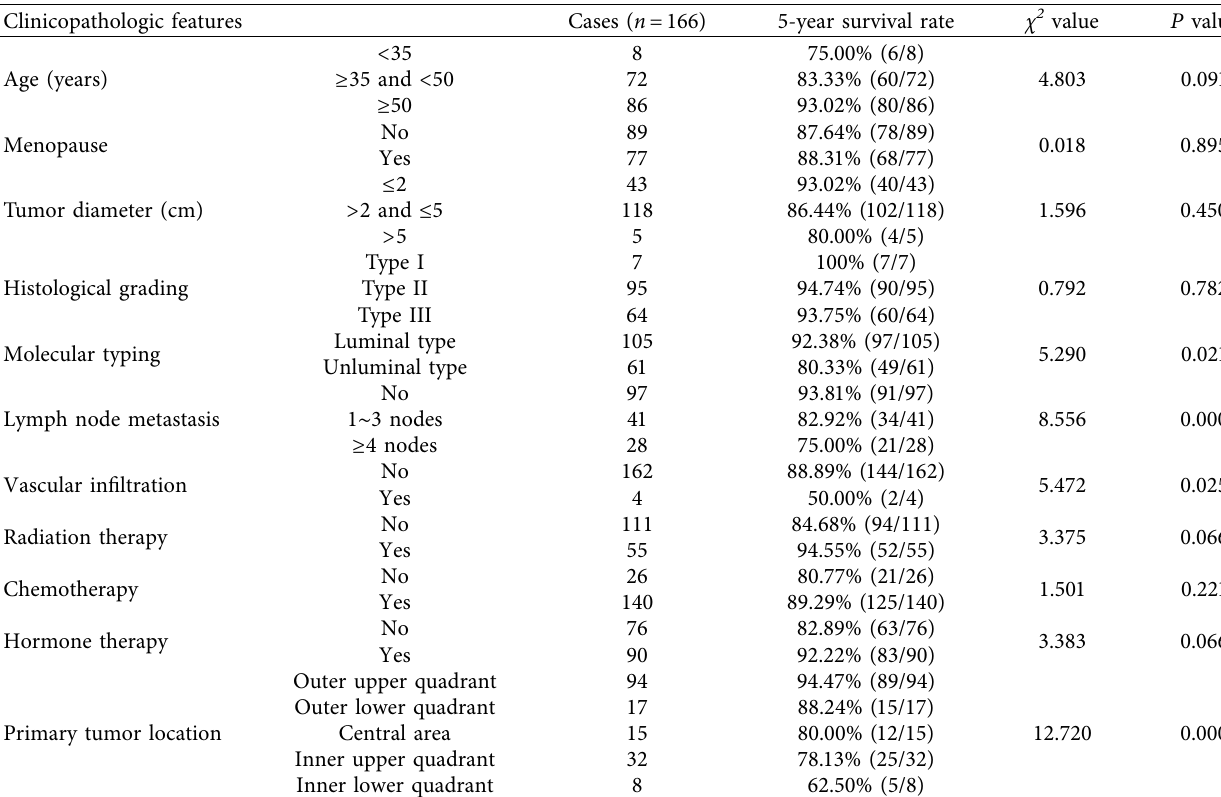
Table 2: Univariate analysis of prognosis of IDC patients after modified radical mastectomy ( n , %).